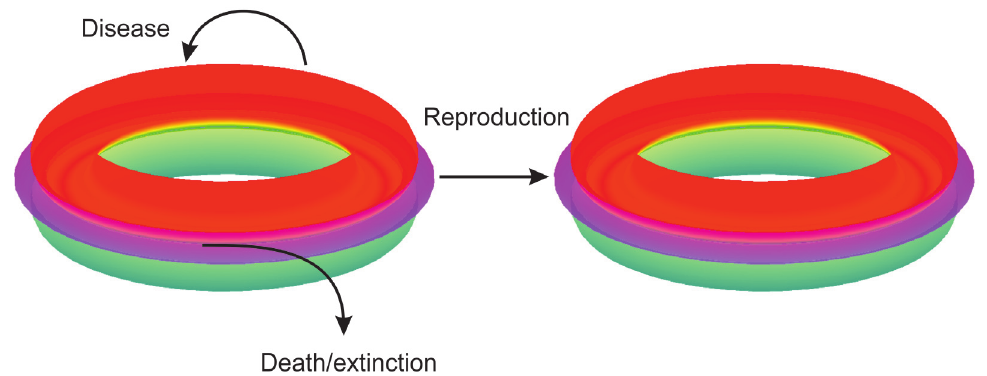
Figure 1. Visualisation of life, disease and death based on the principle of poikilosis. Interconnected tori in red, magenta and green indicate three of the multiple levels that interact and overlap and thereby can affect each other. Processes in living organisms are cyclic, therefore the torus shapes. Matter, energy and information flow in cyclic processes. In disease there is a deviation and by curative treatment it is still possible to return back to normal, lagom level. A large and severe deviation, which is not treated with curative care, can permanently reduce the function and adaptation capacity of the organism. Death in individual level and extinction in population level are irreversible escapes from the system. Reproduction generates new individuals that have their own interconnected